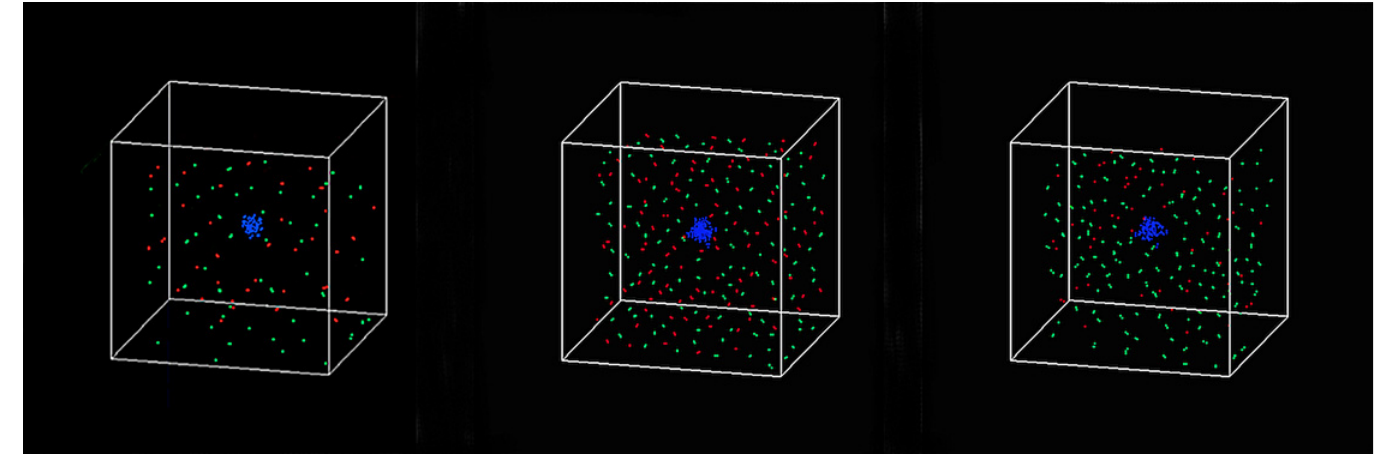
Fig 7. 3D snapshots of the tumor system with single-agent BHQ880 treatment at (a) time step 40, (b) time step 50 and (c) time step 120.